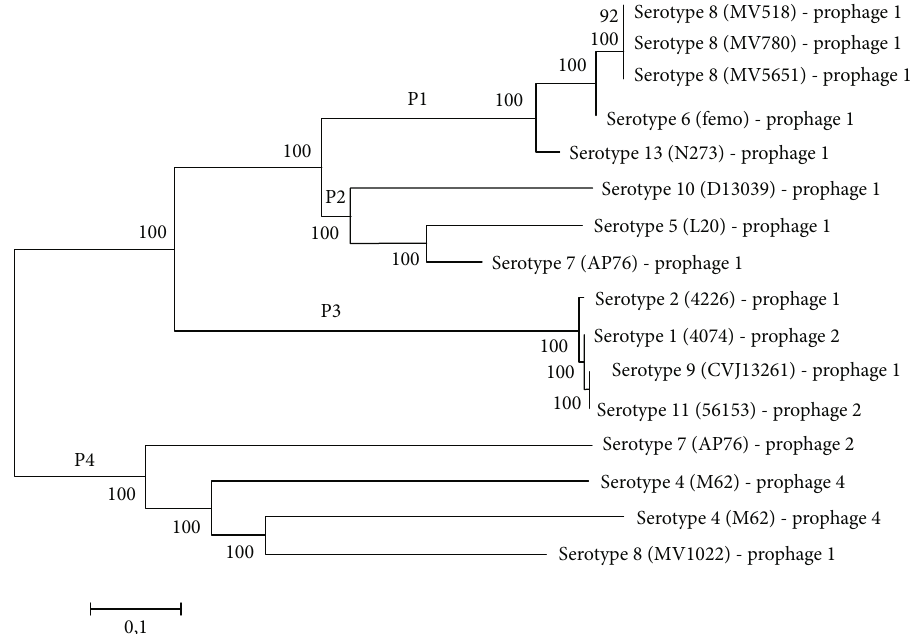
Figure 4: Phylogenetic relationships between sequences related to complete prophages found in A. pleuropneumoniae . The phylogenetic tree using the Neighbor-Joining method with 2000 bootstraps was generated by the MEGA 6 program after alignment by MAFFT and GBLOCKS. The scale is represented below, with 0.1 nucleotide substitutions per site. Table 4: Identi fi cation of complete prophage sequences of A. pleuropneumoniae .